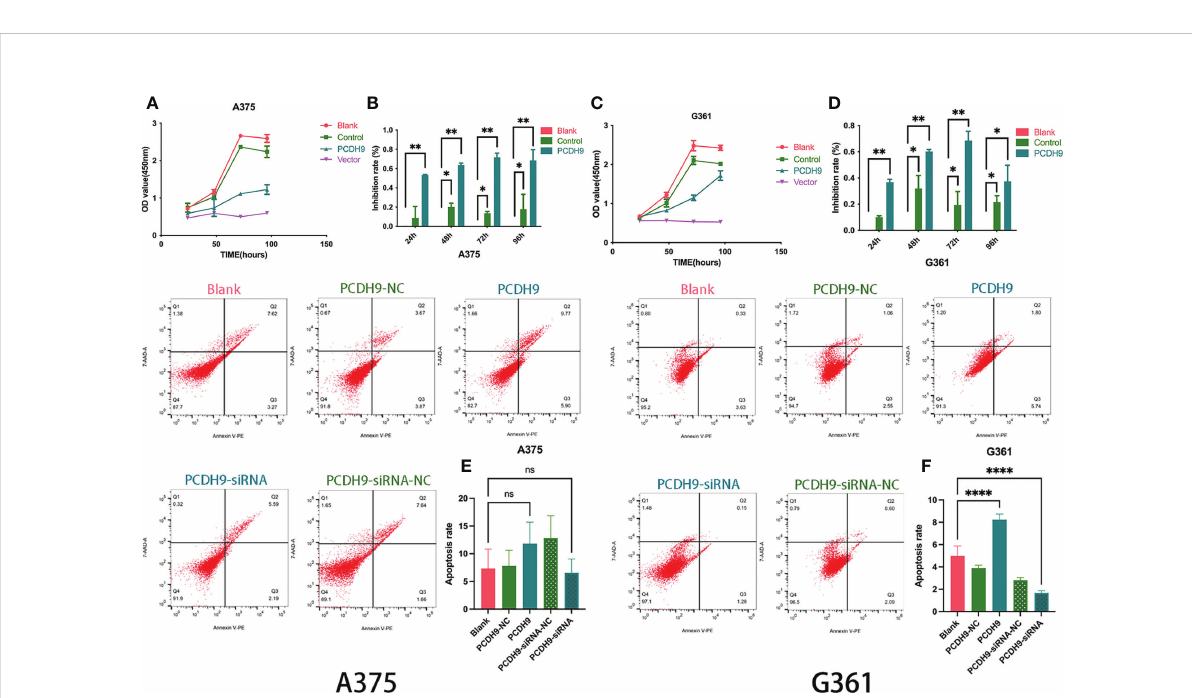
FIGURE 3 The viability of melanoma cells was signi fi cantly reduced by PCDH9 overexpression in A375 (A, B) and G361 (C, D) cells. * p < 0.05, ** p < 0.01, and *** p < 0.001 compared groups using one-way ANOVA followed by least signi fi cant difference post-hoc tests. The alteration of PCDH9 expression signi fi cantly affected the apoptosis of melanoma cells. The overexpression of PCDH9 signi fi cantly promoted apoptosis in G361 cells and a more modest manner in A375 cells, whereas PCDH9 KD reduced apoptosis in G361 cells and a more modest manner in A375 cells (E, F) . ns P > 0.05, * p < 0.05, ** p < 0.01, and **** p < 0.0001 compared with blank group by using Student ’ s t